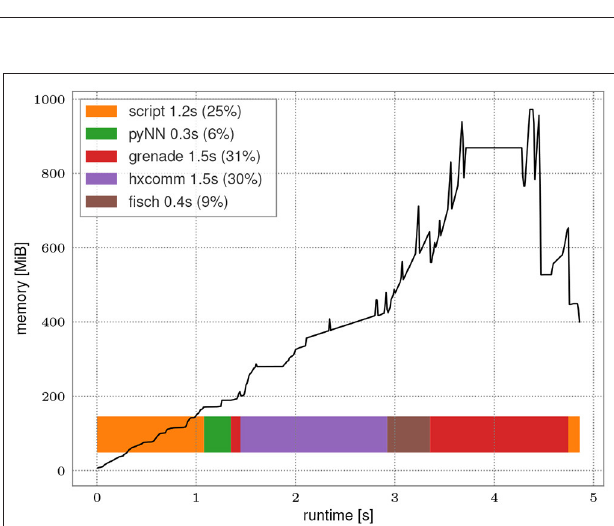
FIGURE 7 | Comparison between lola.AtomicNeuron and pynn.HXNeuron .